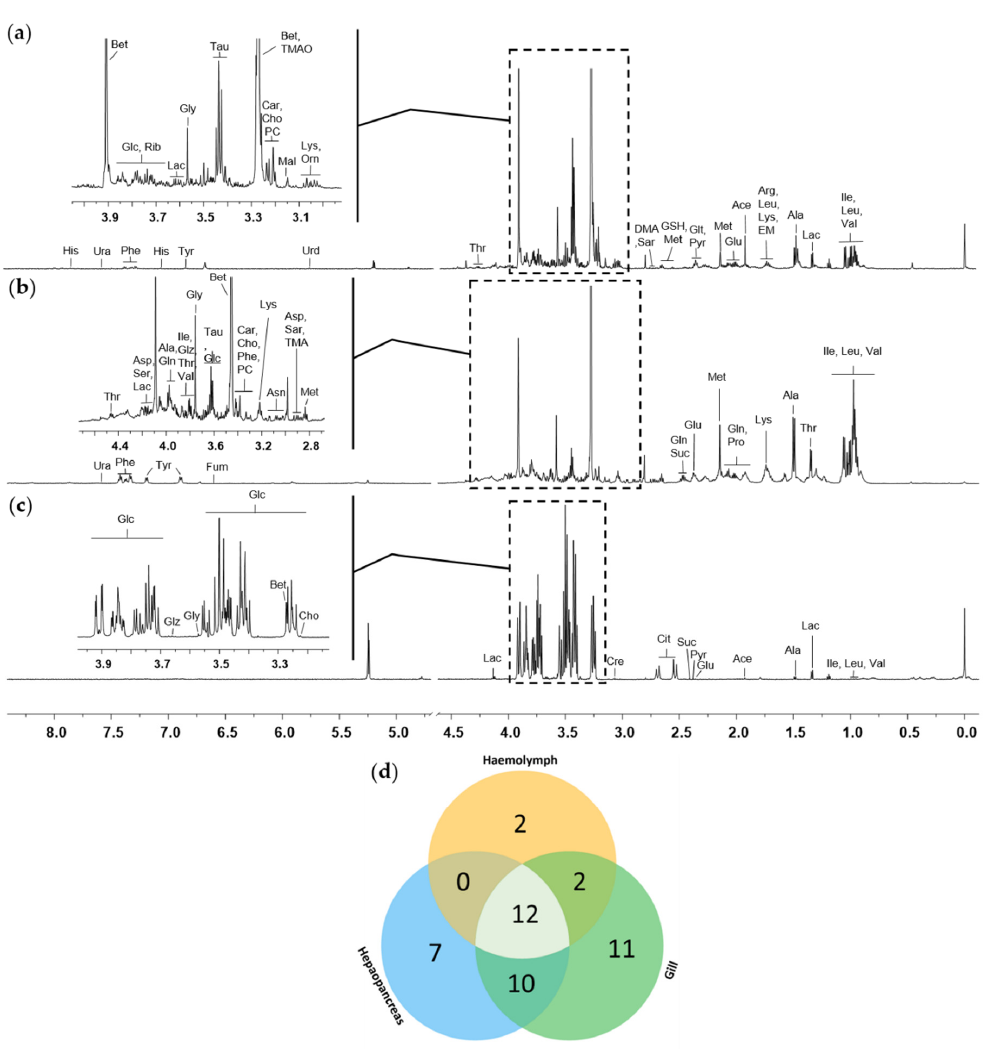
Figure 1. Representative 1 H NMR spectra of intact gills ( a ), hepatopancreas ( b ), and haemolymph ( c ) tissues of whiteleg shrimp in the control group. The y -axis indicates peak intensity. Labelled peaks